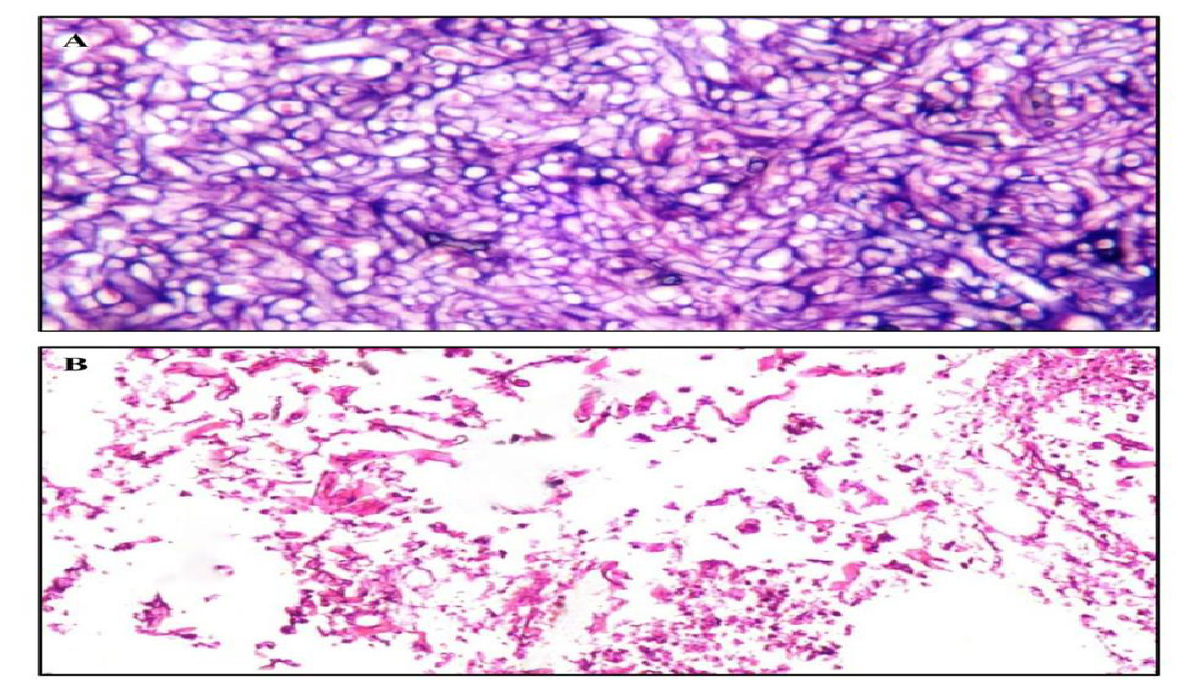
Figure 3. Aspergillus ball in the nasal cavity (H&E×200). (B): Mucormycosis hyphae within the nasal cavity